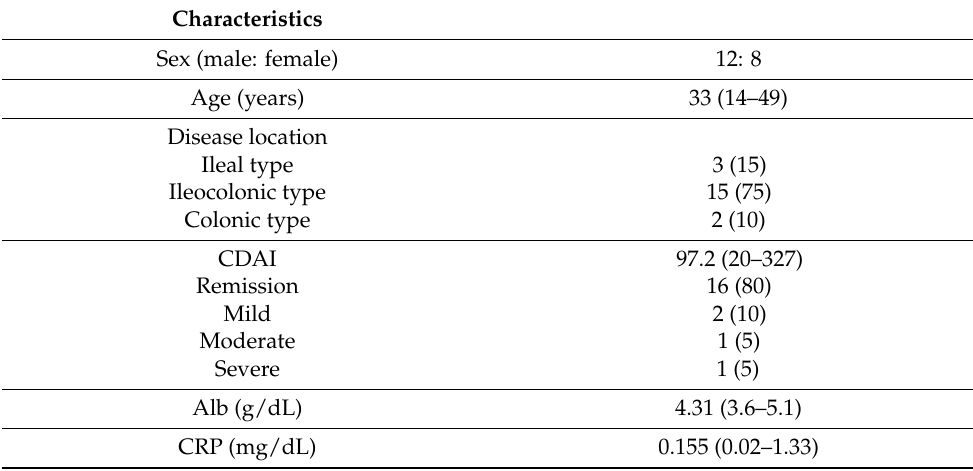
Figure 1. Flow chart of study patient selection. Table 1. Patient